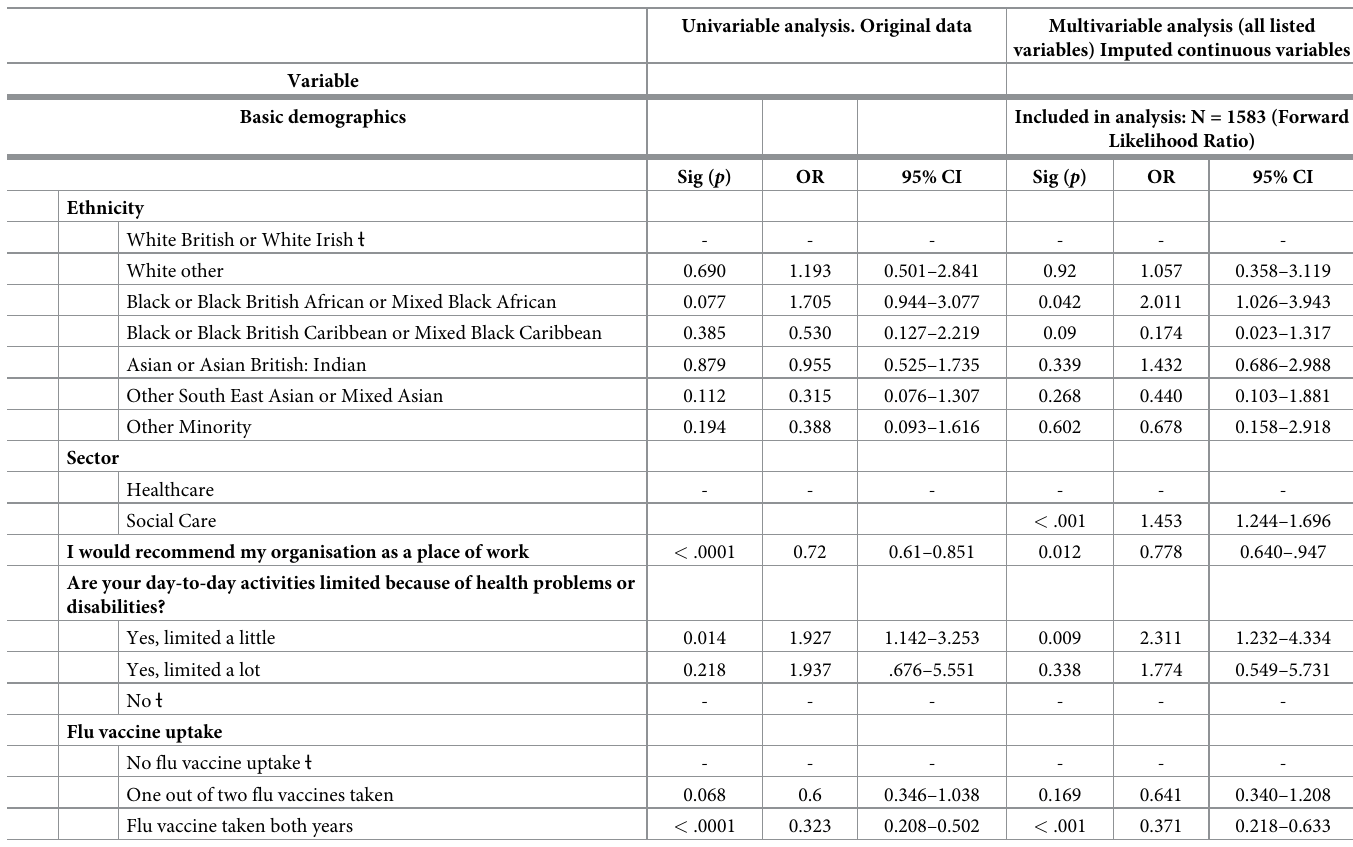
Table 5. A logistic regression analysis of not being offered a COVID-19